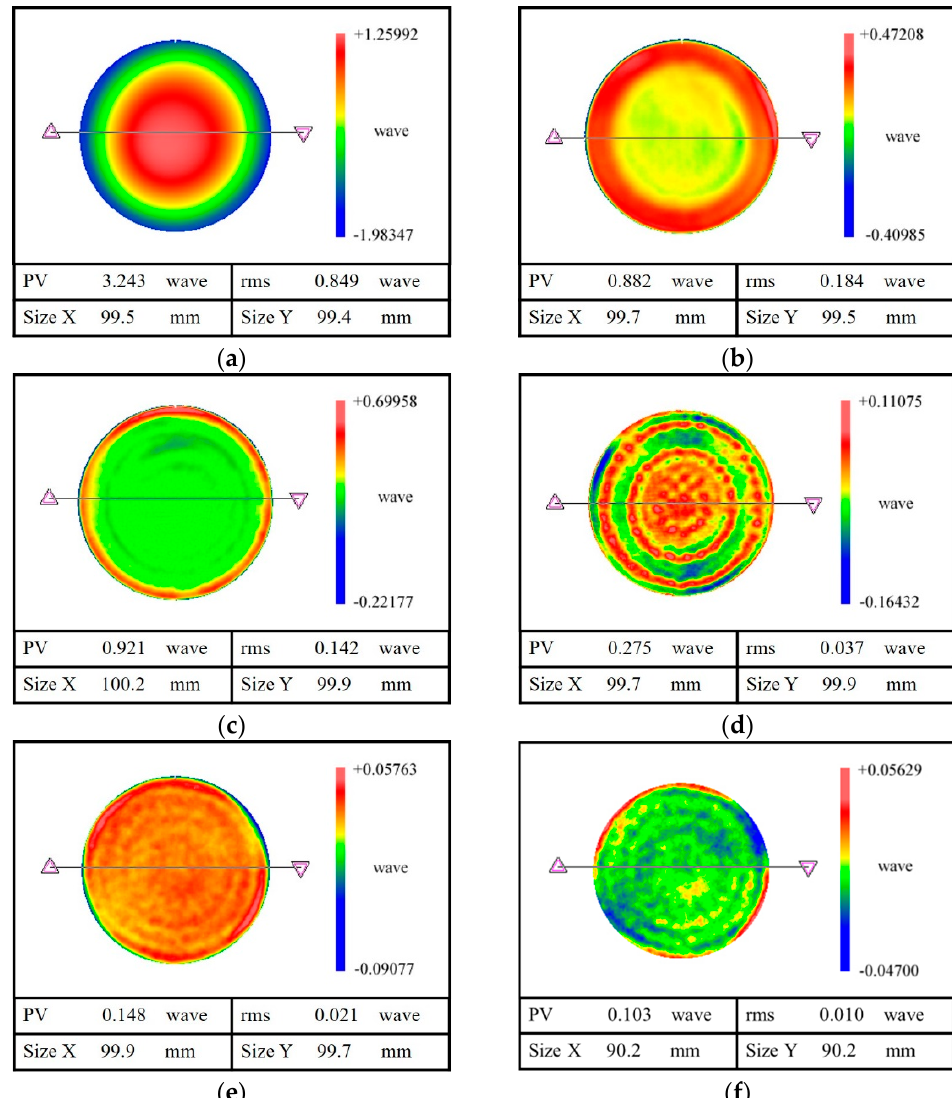
Figure 7. Surface error after combined polishing process. ( a ) initial surface errors, ( b ) surface errors after the double–rotor polishing with large tool, ( c ) surface errors after the double–rotor polishing with a small tool, ( d ) surface errors after the spin–polishing, ( e ) surface errors after the combined polishing method, ( f ) surface errors of 90% area after the combined polishing method.